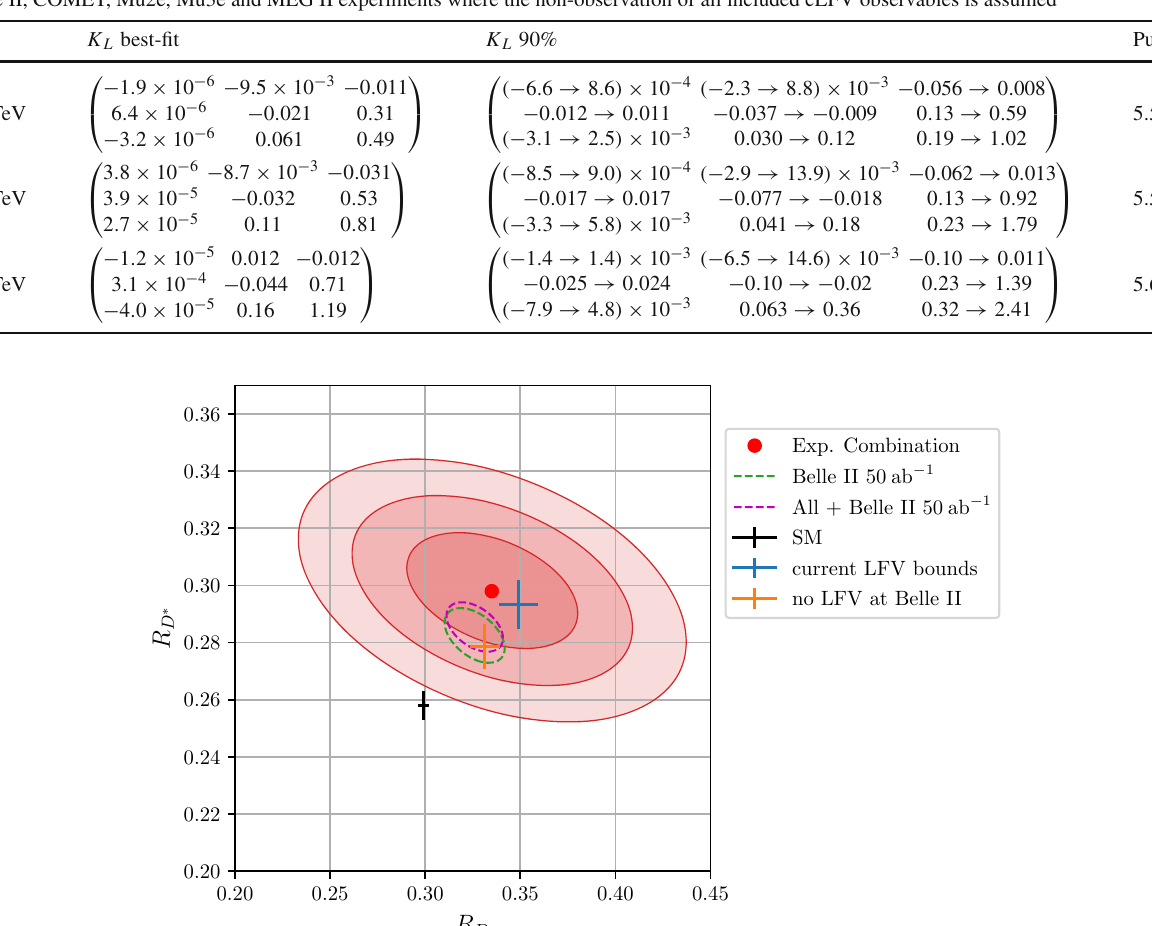
The black cross denotes the SM prediction [5]. The green dashed con- tour line describes the naïve extrapolation of the current combination of Belle data [6,10,11] to the anticipated future precision of the Belle II experiment, while the purple dashed contour line is a naïve combination of the Belle II projection with the current